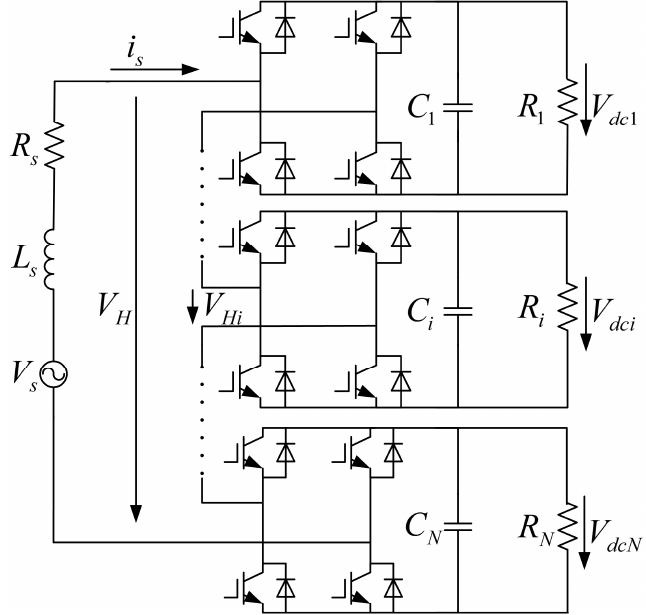
Figure 1. Topology of the cascaded H-bridge rectifier (CHBR).